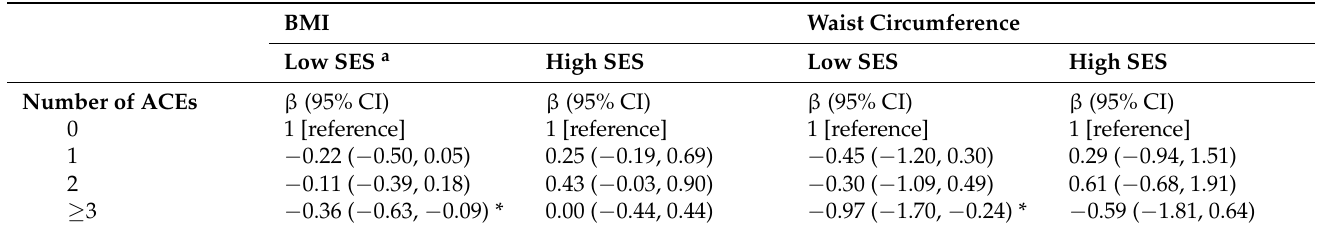
Table 4. Associations of the number of ACEs with BMI and waist circumference in different SES